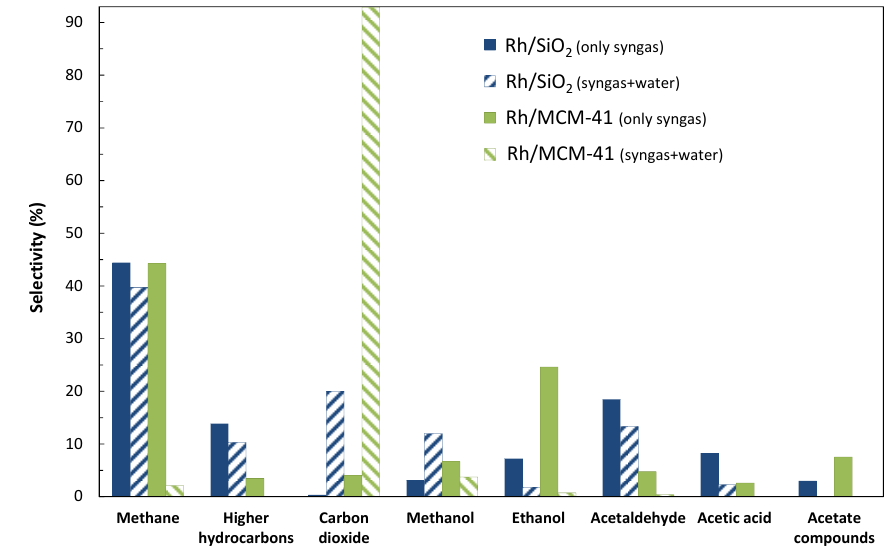
Figure 2. Comparison of the product selectivities obtained from the conversion of syngas with and without addition of water over Rh/SiO 2 and Rh/MCM-41. Reaction conditions (with addition of water): 280 °C, 20 bar, GHSV = 6000 mL syngas /g cat ·h (H 2 :CO:H 2 O = 2:1:2.7) for Rh/SiO 2 and GHSV = 3000 mL syngas /g cat ·h (H 2 :CO:H 2 O = 2:1:1.5)